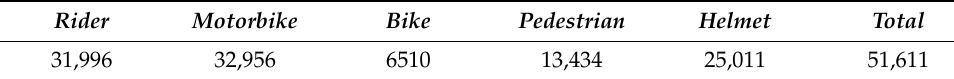
Table 1. The number of per subclass on RIDER dataset.